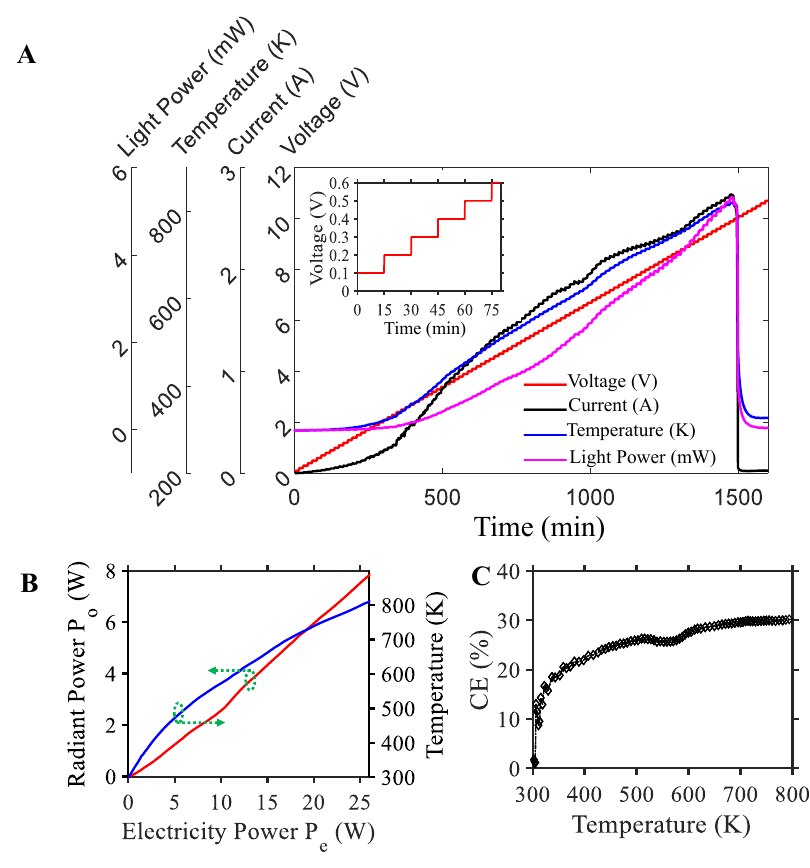
Figure 4: The thermal photonic dynamics of the electrically controlled LTEs. (A) The evolution of the current, the surface temperature, and the radiated power (detected at the exit port of the integrating sphere) to the input electrical voltage that increaseswithastepof0.1Vper15min.The insetplotsthezoom-inofthevoltageversus time. The light radiated from the LTEs propagates through the KBr window of the vacuum chamber and enters the integrating sphere through the input port, and then is detected by a photodetector at the exit port of the integrating sphere. (B) The dependenceoftheradiantlightpower P o (at the input port of the integrating sphere) on theinputelectricalpower P e andthesurface temperature of the LTEs. (C) The electro- optical conversion ef fi ciency CE = P o / P e of the LTEs. The thickness of the structure nanolayers are the same as those in Figure 3, and the structure width is w = 20 mm and length is l = 10